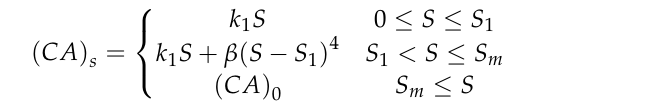
Here, m f is the added mass and the subscript s denotes the main chute. The drag area of the parachute during inflation is dependent on the inflation distance